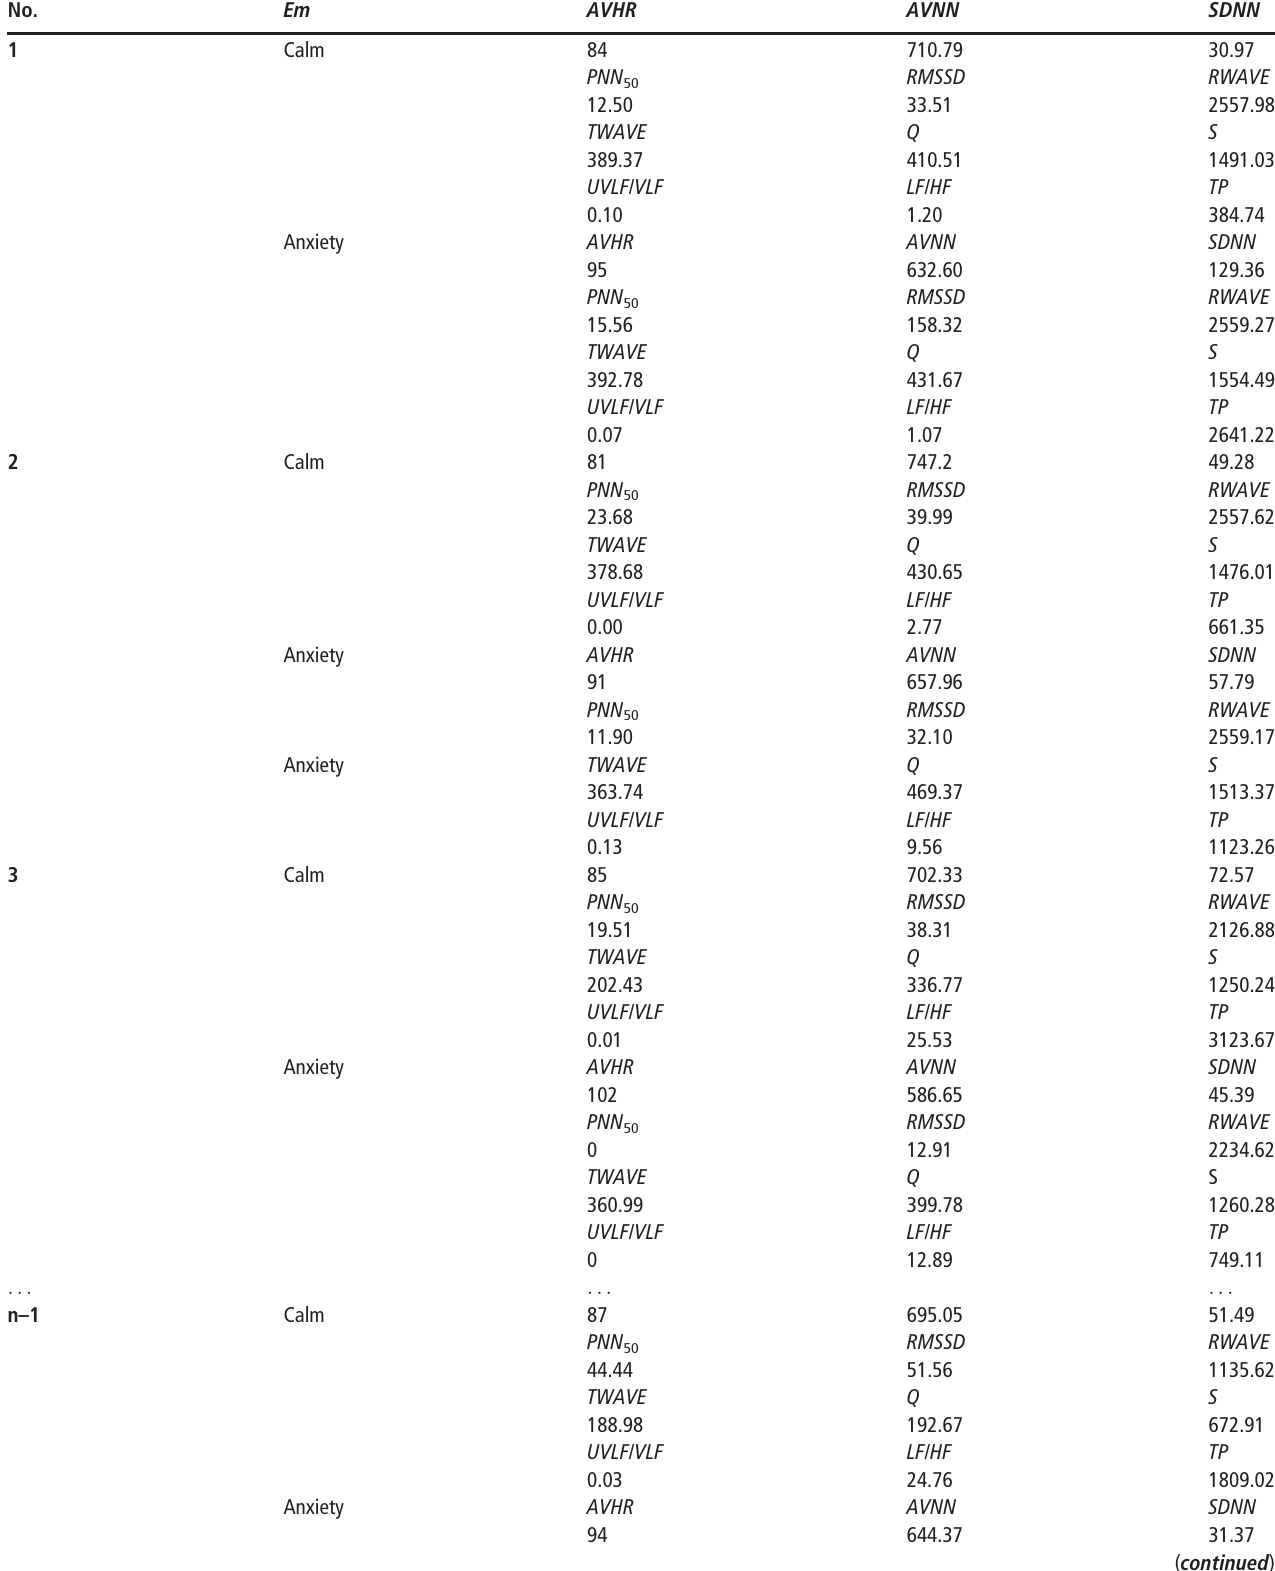
Table VI Statistics of driver ’ s ECG characteristic data